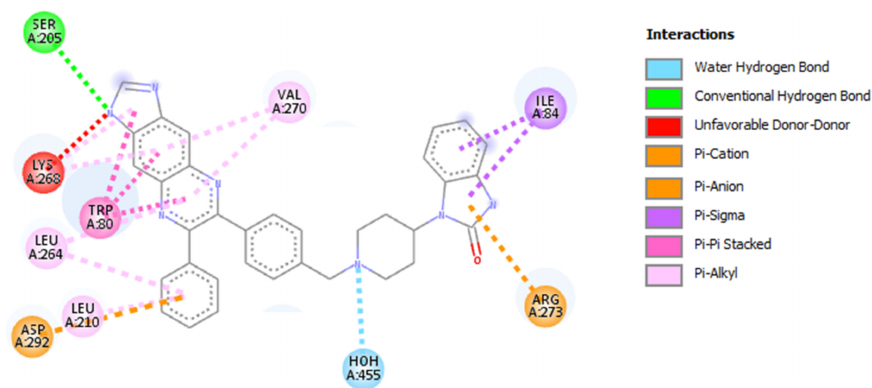
Figure 2. Amino acids of AKT1 that interact with IQO. The figure presents the schematization of the IQO interaction with AKT1, obtained with DiscoveryStudio. Van der Waals interactions are not shown to make more readable the scheme.